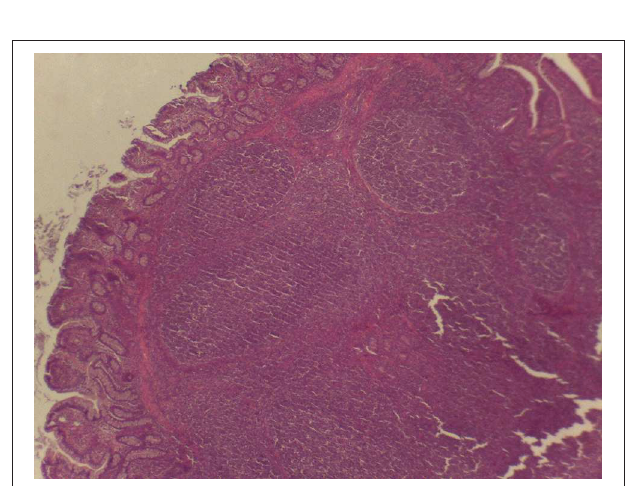
FIGURE 4 | Microscopy of PPs in pigs from the experimental group fed with the CM diet.